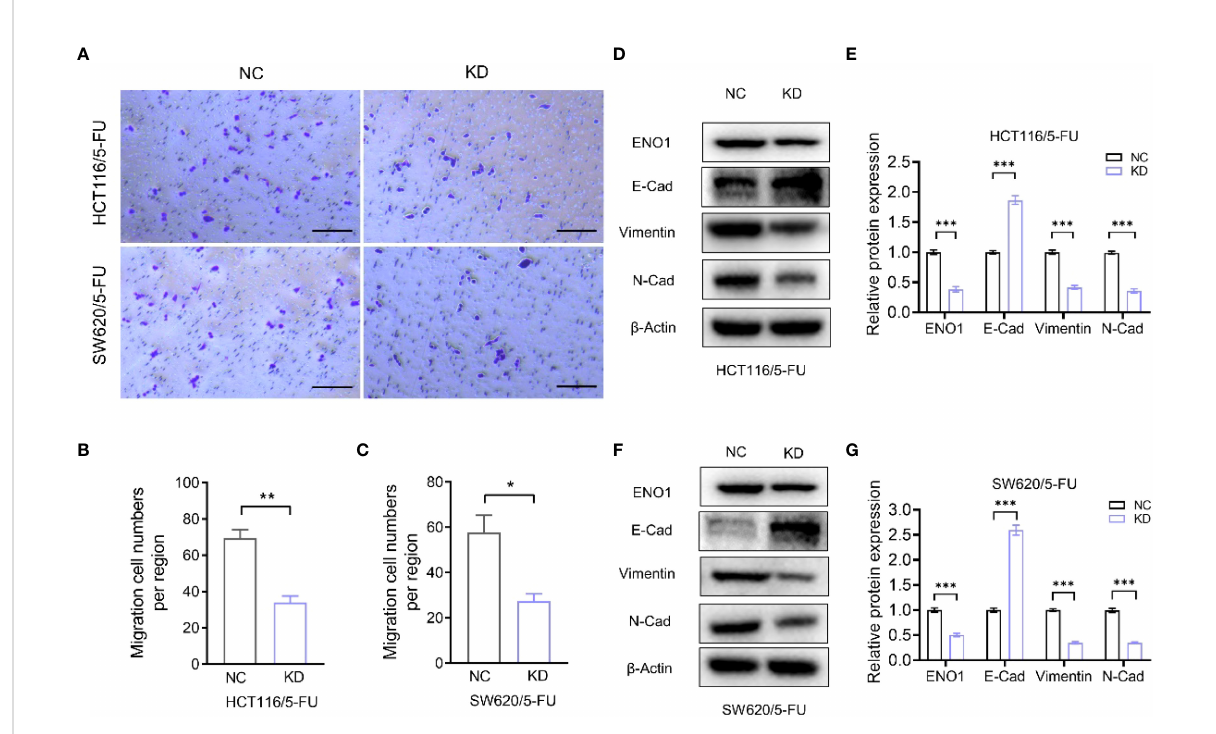
FIGURE 5 ENO1 knockdown inhibited the migration of resistant cells and was associated with the EMT process. (A – C) Display of representative photographs (A) in the ENO1-KD and NC groups and the number of migration cells in HCT116/5-FU cells (scale bar = 100 m m) (B) and SW620/ 5-FU cells (C) . (D, F) Western blotting of E-Cadherin, N-Cadherin, and Vimentin expression levels following knockdown of ENO1 in HCT116/5- FU cells (D) and SW620/5-FU cells (F) . (E, G) The bands were quanti fi ed and are presented as mean ± SEM of three independent experiments in HCT116/5-FU cells (E) and SW620/5-FU cells (G) . Statistical analyses were performed via two-tailed Student t test. *, P ≤ 0.05; **, P ≤ 0.01; ***, P ≤